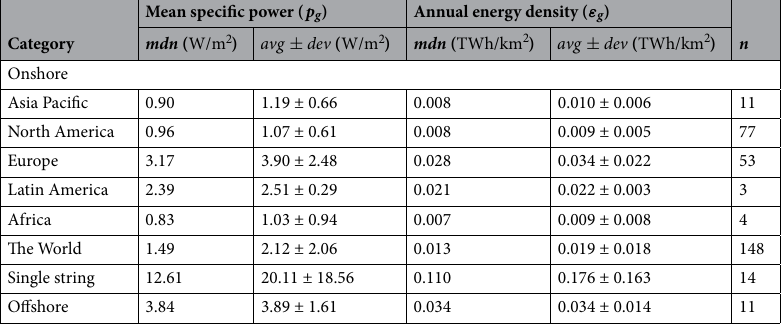
Table 11. Mean and annual power and energy densities for regular onshore wind power on the different continents, single-string onshore wind power, and offshore wind power.